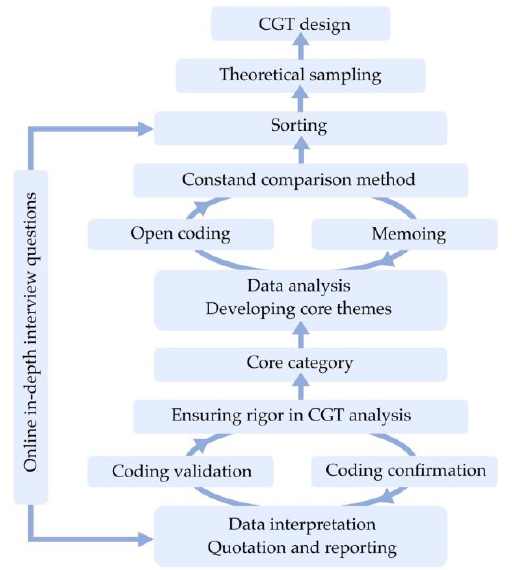
Figure 1. CGT design.